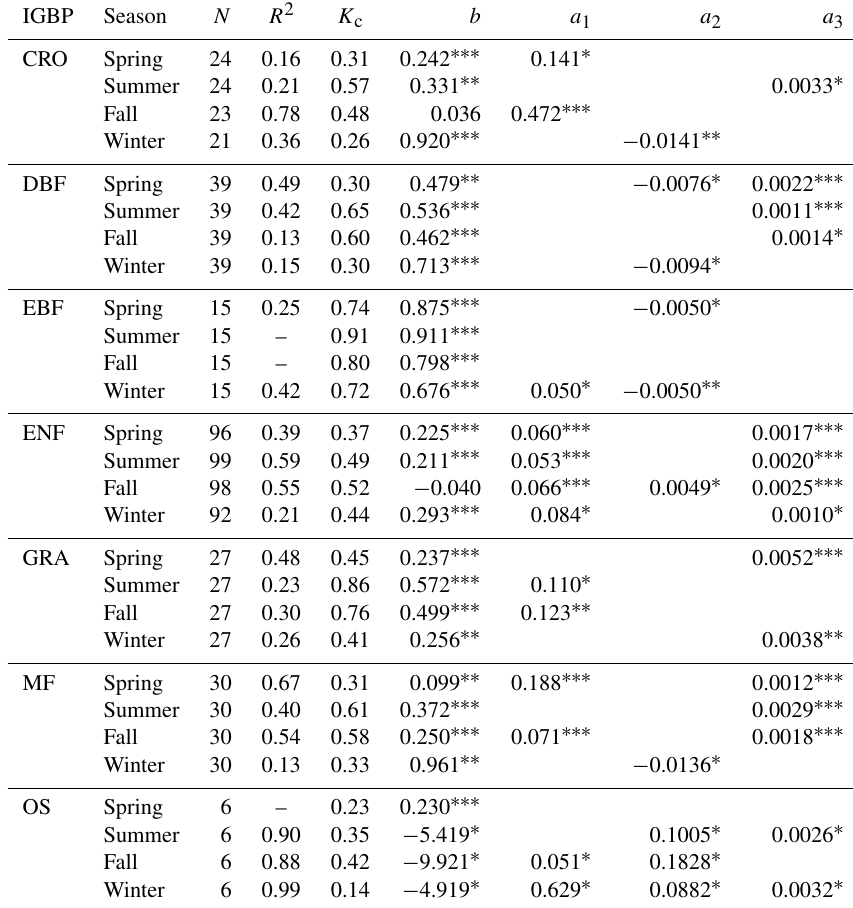
Table 1. Multiple linear regression relationships among crop coefficient and LAI, precipitation, and site latitude in different seasons.